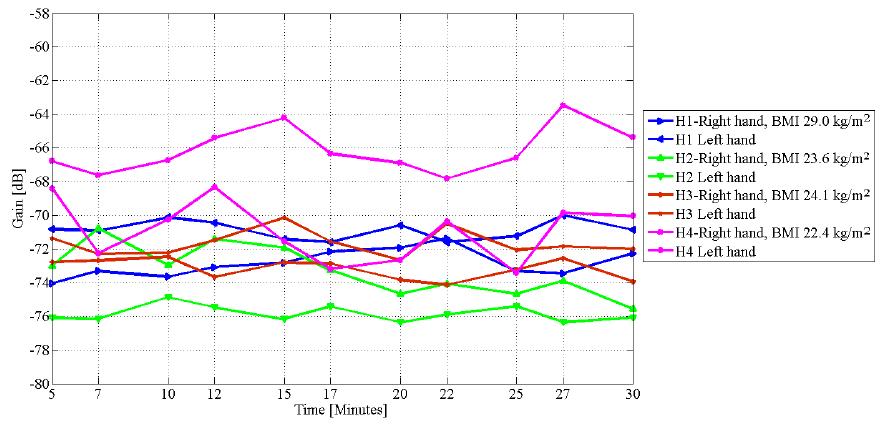
Figure 4. Measurement of galvanic coupled signal gain at 900 kHz, on both arms of healthy subjects without fluid restriction.